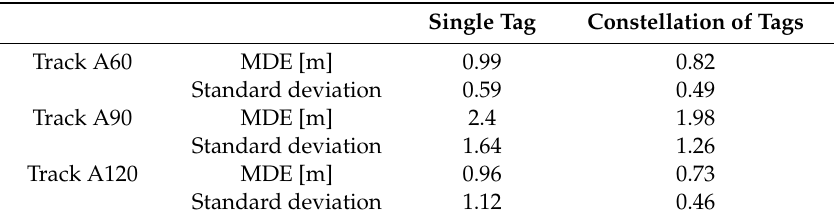
Table 3. The mean estimated distance errors based on real measurements.